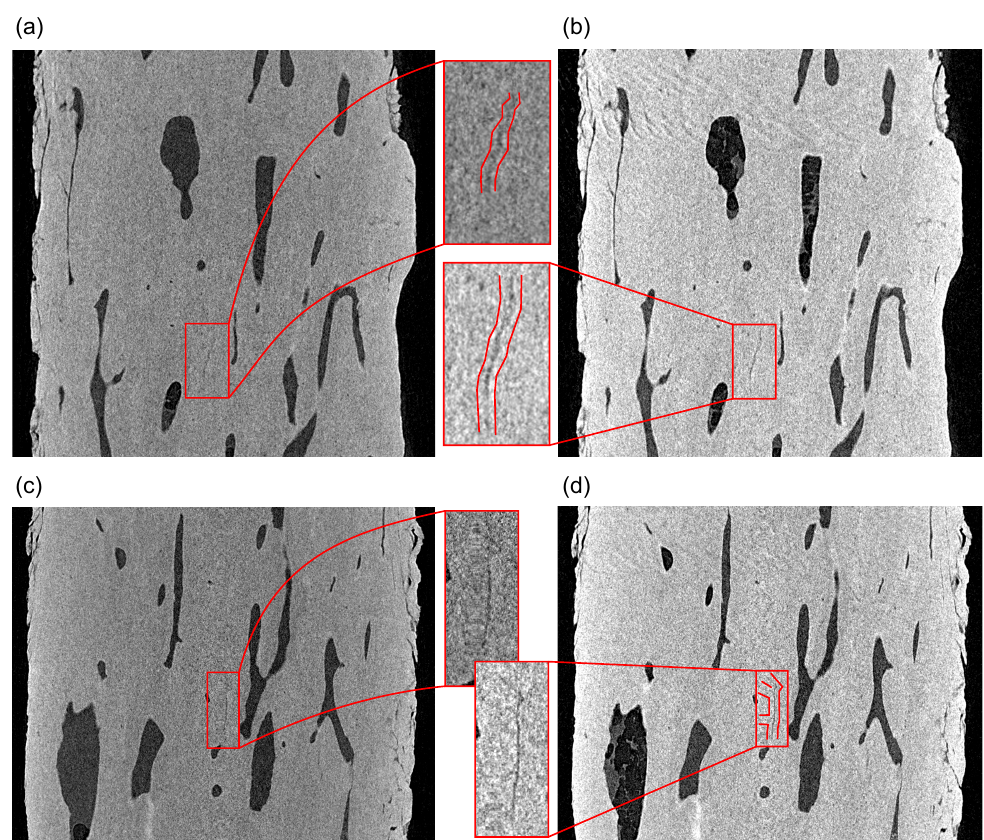
Figure 12. Perpendicular slices through the reconstructed 3D volumes at the symmetry axis of the specimen: ( a , b ) sagittal and ( c , d ) coronal plane. The growth of the microcracks is shown in comparison to the intact state ( a , c ) and the loaded state ( b , d ). The figure depicts in red color the microcracks with increased dimensions as a result of the loading